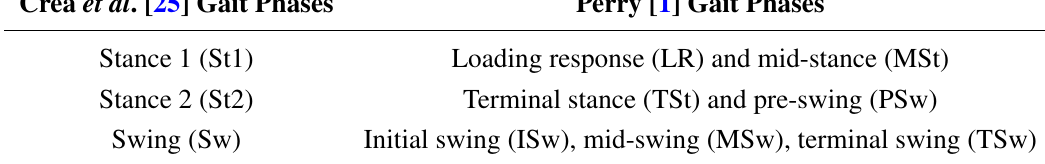
Table 1. Relationship between gait phases detected by Crea et al. [25] and Perry’s gait cycle phases